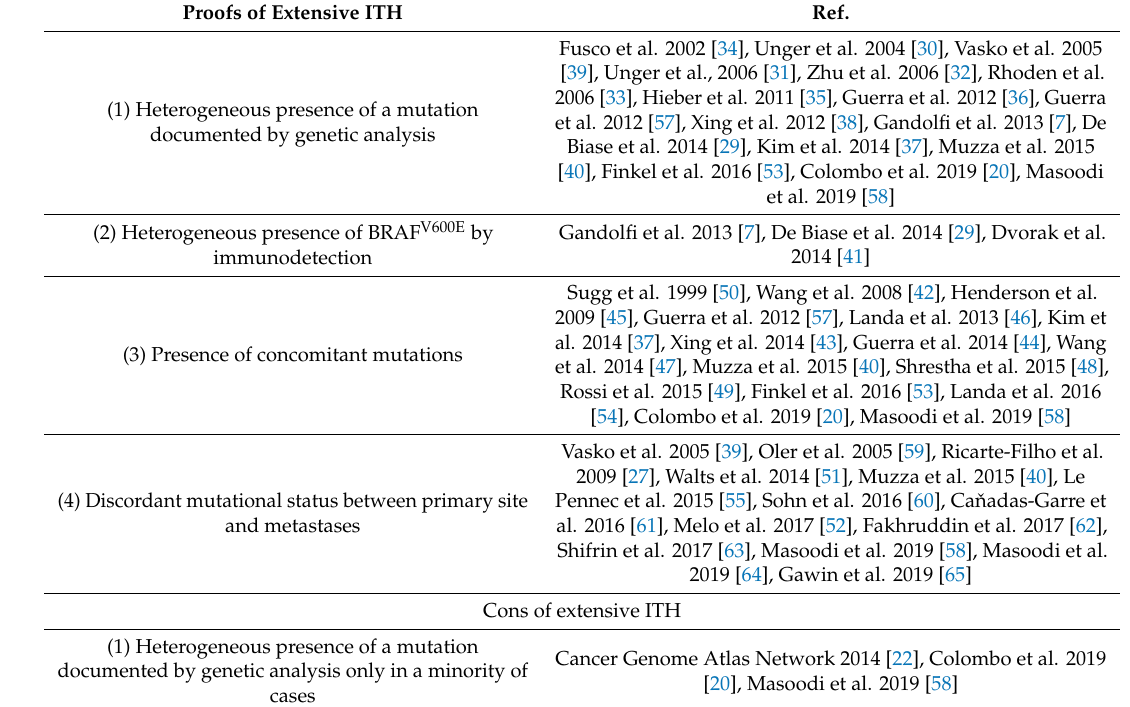
Table 1. Arguments in favor and in contra on the presence of extensive intratumoral heterogeneity (ITH) in papillary thyroid